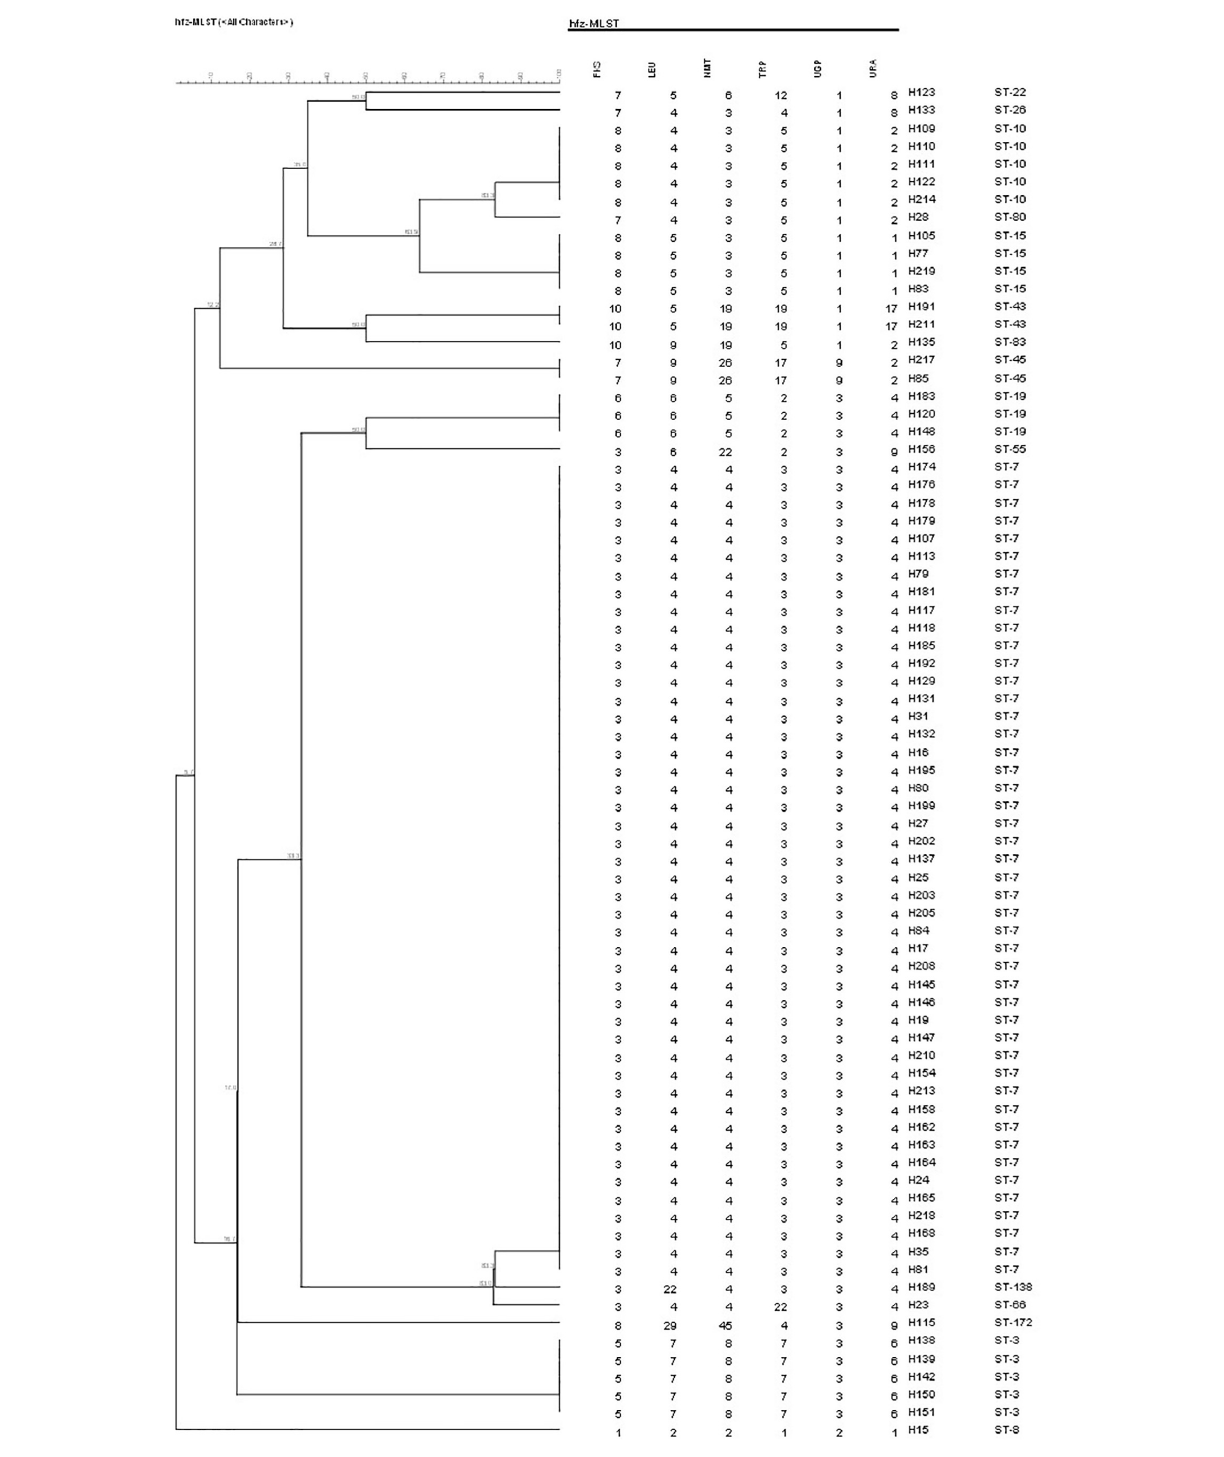
Frontiers in Microbiology |